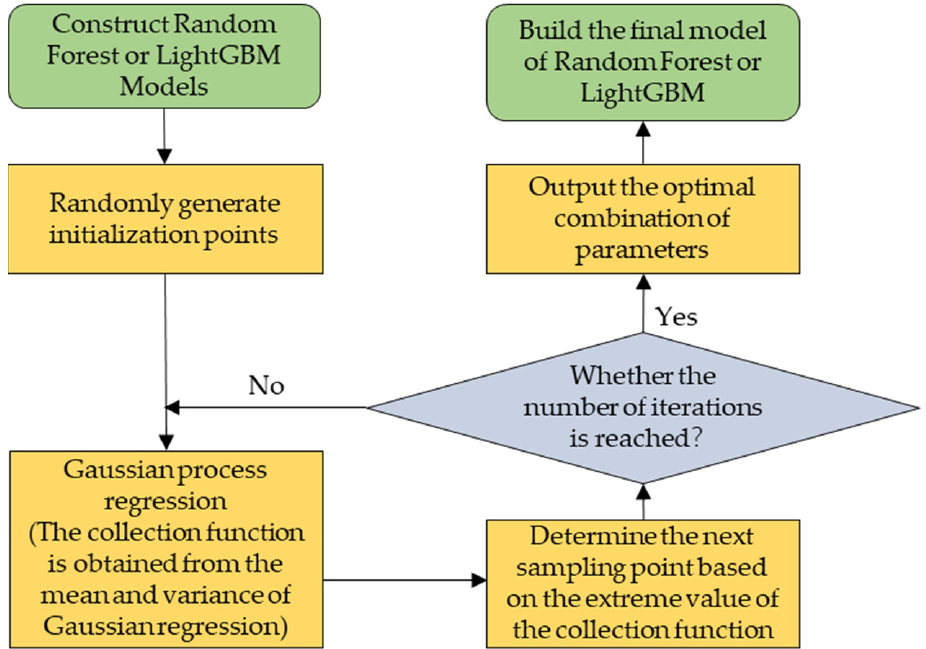
Figure 5. Flowchart of the Bayesian Optimization Algorithm.